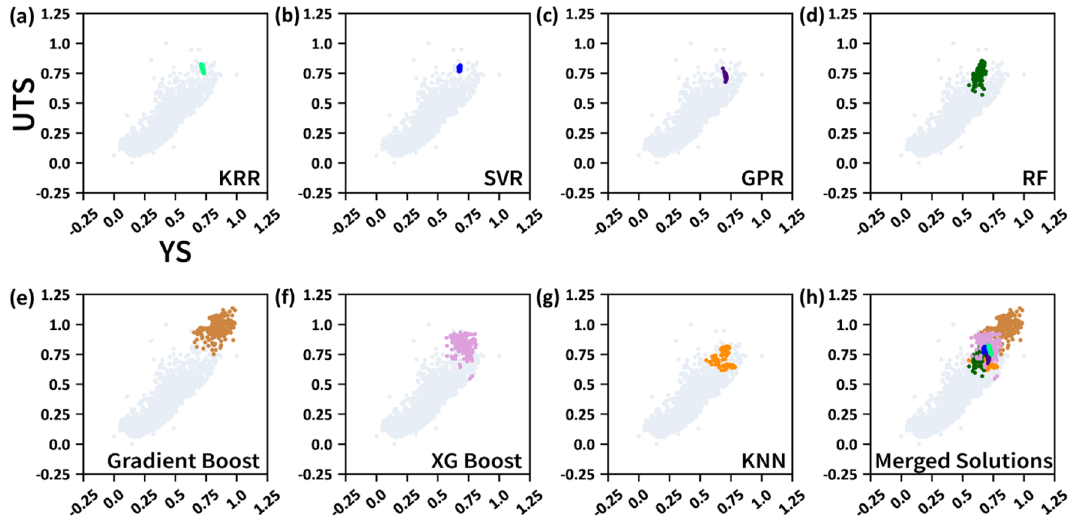
Figure 4. The inverse-predicted (NSGA-II-maximized) YS and UTS for ( a ) KRR, ( b ) SVR, ( c ) GPR, ( d ) RF, ( e ) Gradient Boost, ( f ) XG Boost, and ( g ) KNN regression models, obtained from the NSGA-II-driven inverse prediction for the seven non-linear ML algorithms along with the entire dataset, marked in different colors. ( h ) the merged solutions from all the seven ML algorithms. The entire dataset was also plotted as a